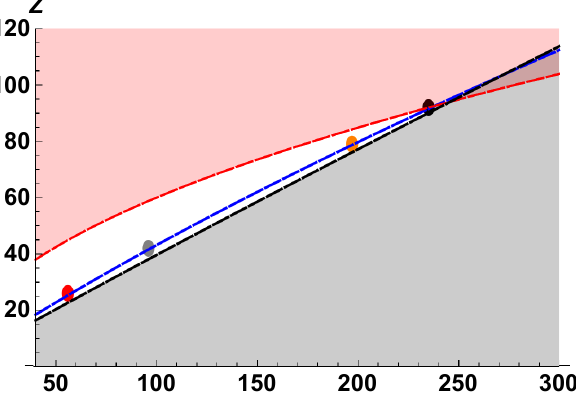
Figure 9. Placement of critical lines: β -line (blue), n -line (black), and fission-limit f -line (red). In the shaded gray zone, neutron-emission takes place. In the shaded red zone, fission takes place. In the zone below the blue line, β − -emissions take place. Four dots denote locations of Fe (red dot), Mo (gray dot), Au (yellow dot), and U (black